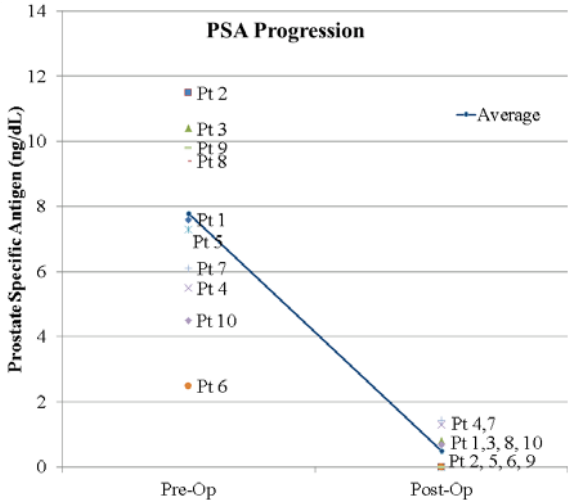
Figure 1 - Changes in PSA; pre versus post-operative PSA for each patient and the average PSA level (ng/mL).